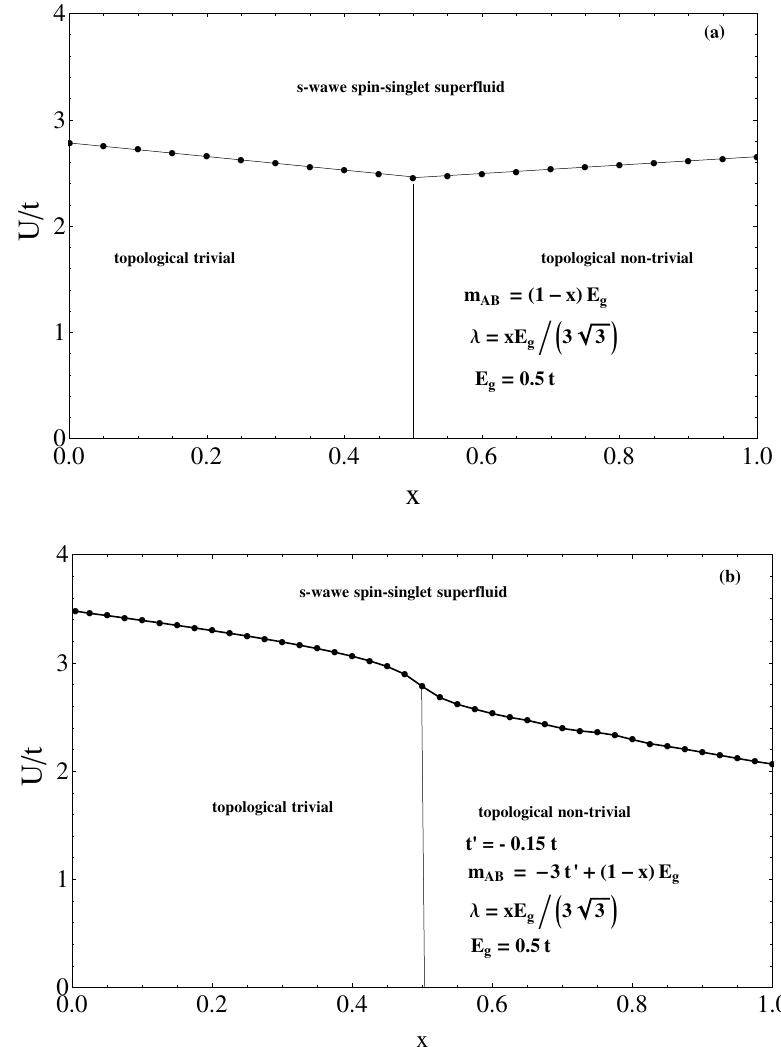
Figure 2. Phase diagrams of the attractive Kane–Mele–Hubbard model as functions of the tuning √ √ parameter x = 3 3 λ / ( 3 3 λ + 3 t (cid:48) + m AB ) . Solid lines mark topological phase transitions between the topological non-trivial and trivial insulating states, and the s-wave spin-singlet superfluid state: ( a ) without the NNN term ( t (cid:48) = 0), and ( b ) with ( t (cid:48) = − 0.15 t